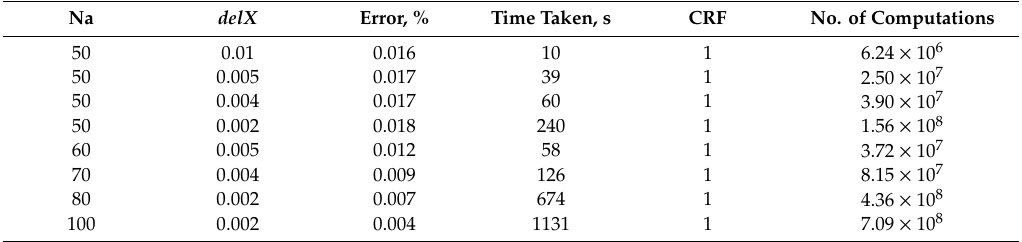
Table 5. Computation of view factor using NUGP routine. Example with perpendicular, whole surfaces, uniform reflectance. Routine: Non Uniform Grid Populous, NUGP*.